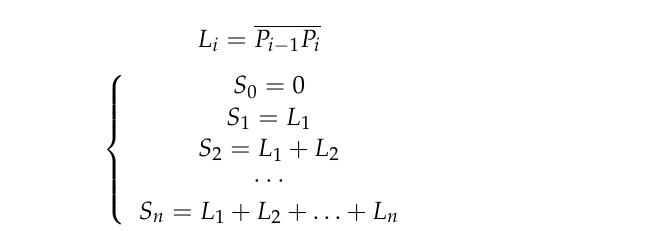
f 0 . Divide f 1 , f 2 , f 3 , · · · , f n and f 0 into several parts by the racks, and define the parts as f ij ( i = 1, 2, · · · , n ; j = 1, 2, · · · , 6 ) , where i represents the i -th point among n points, and